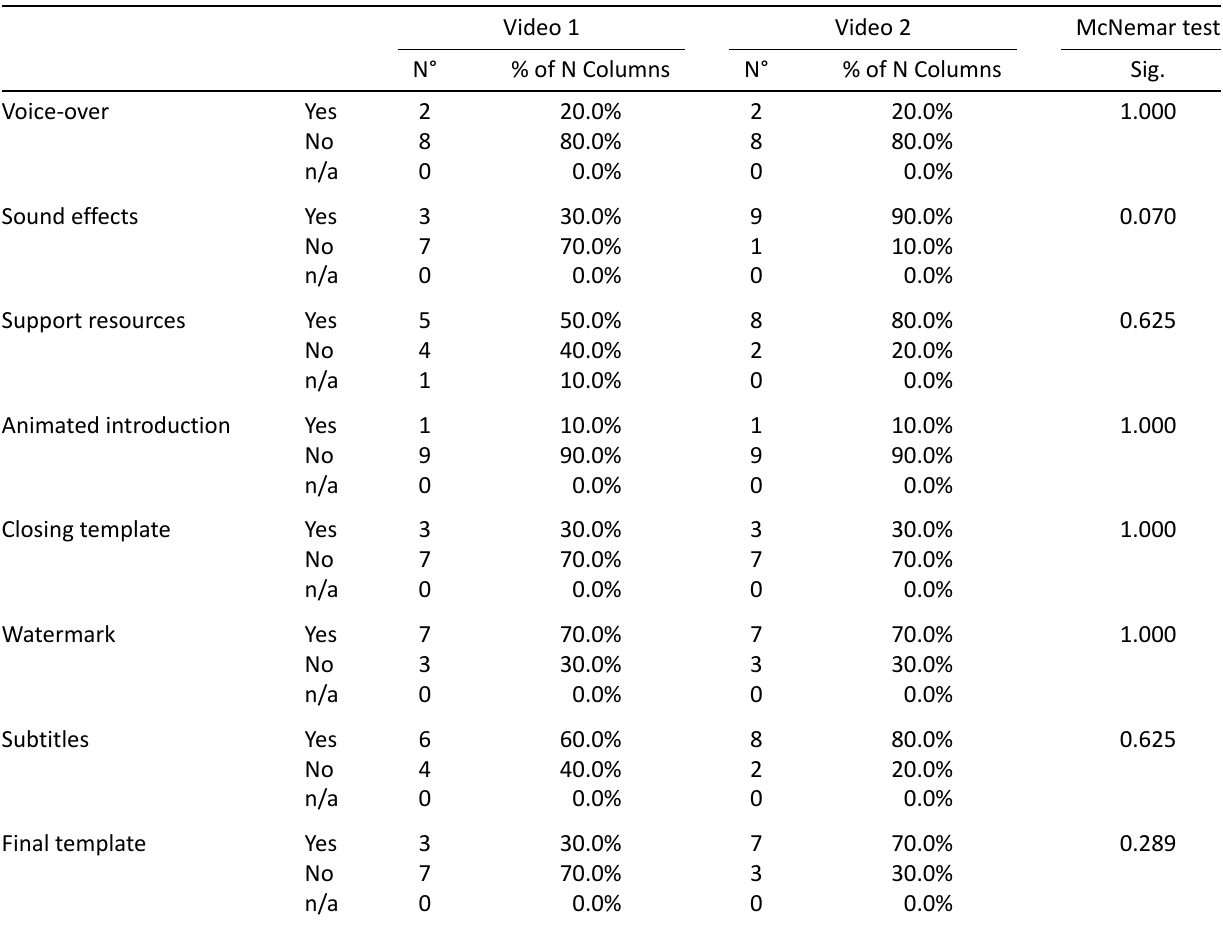
Table 6. McNemar test: Technical aspects of Videos 1 and